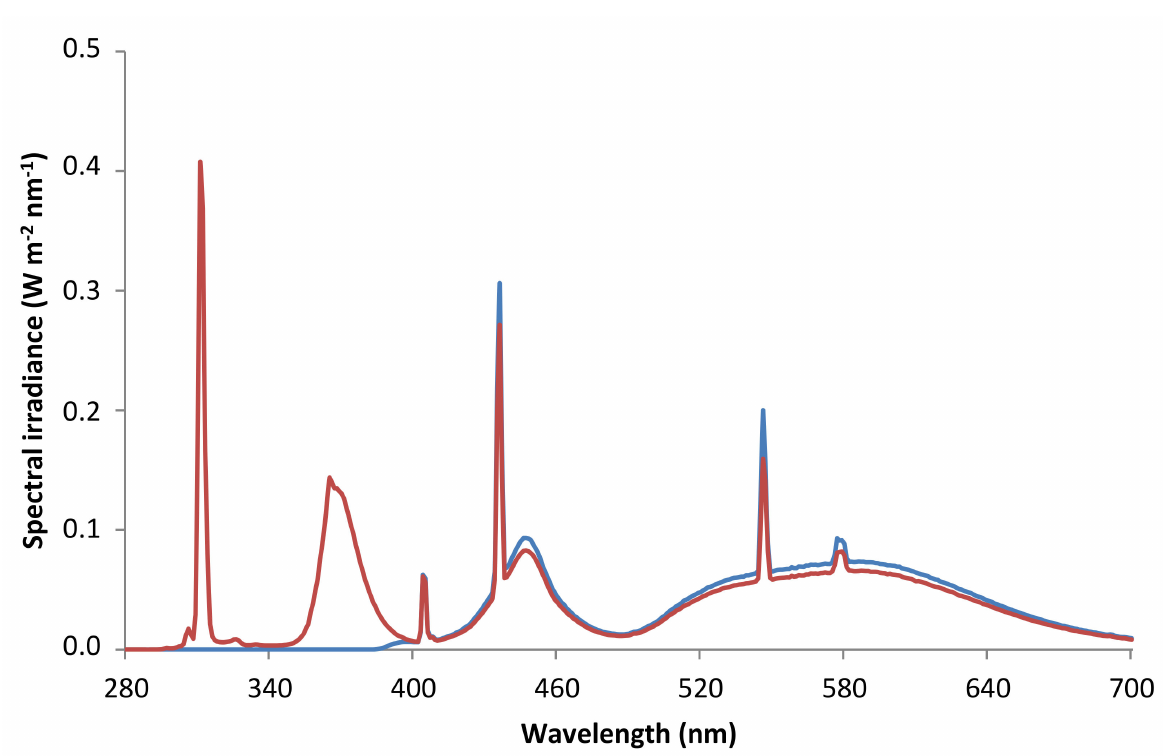
Figure 4. Spectral irradiance (280–700 nm) received by samples of the thalloid liverwort Marchantia polymorpha subsp. ruderalis (Tak-1 accession) under the two radiation regimes imposed in the experiment: P (only PAR, blue line), and PAB (PAR + UV-A + UV-B, red line).